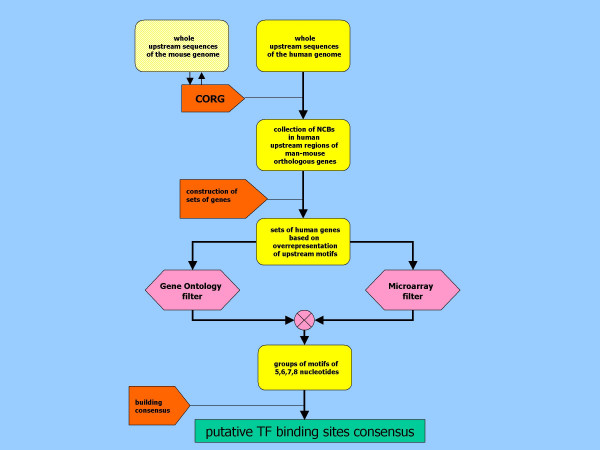
Flow-chart of the algorithm